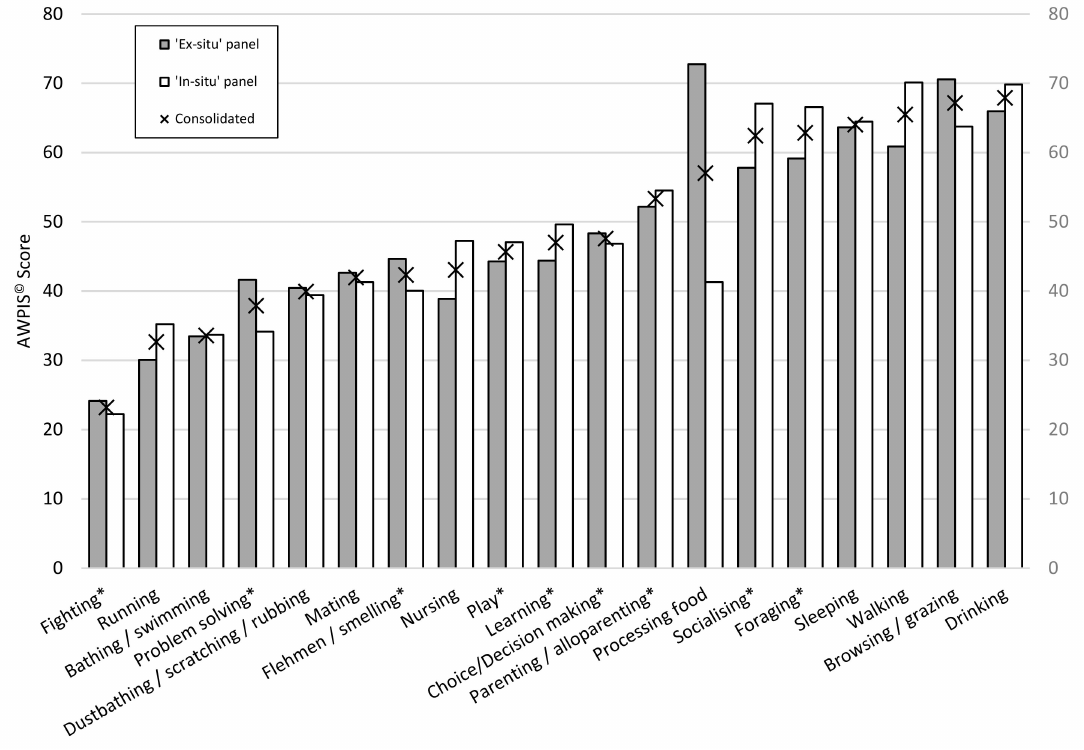
Figure 2. AWPIS © scores for each behaviour and cognitive process for ‘ex-situ’ assessments (grey bars) and ‘in-situ’ assessments (open bars), together with data consolidated from both ‘in-situ’ and ‘ex-situ’ assessments (marked with an X) by which behaviours and cognitive processes are ultimately ranked. * Denotes cognitive process or behaviours with significant cognitive components to